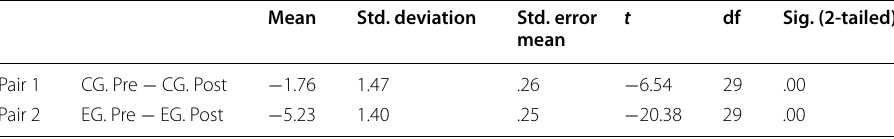
Mean Std. deviation Std. error